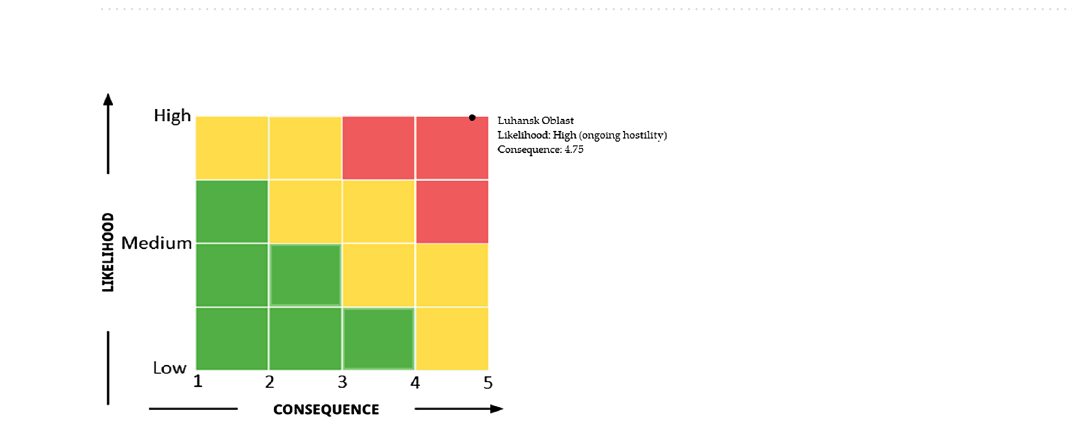
Table 5. Score assigned to each consequences indicator if the chemical facilities cluster being bombarded.